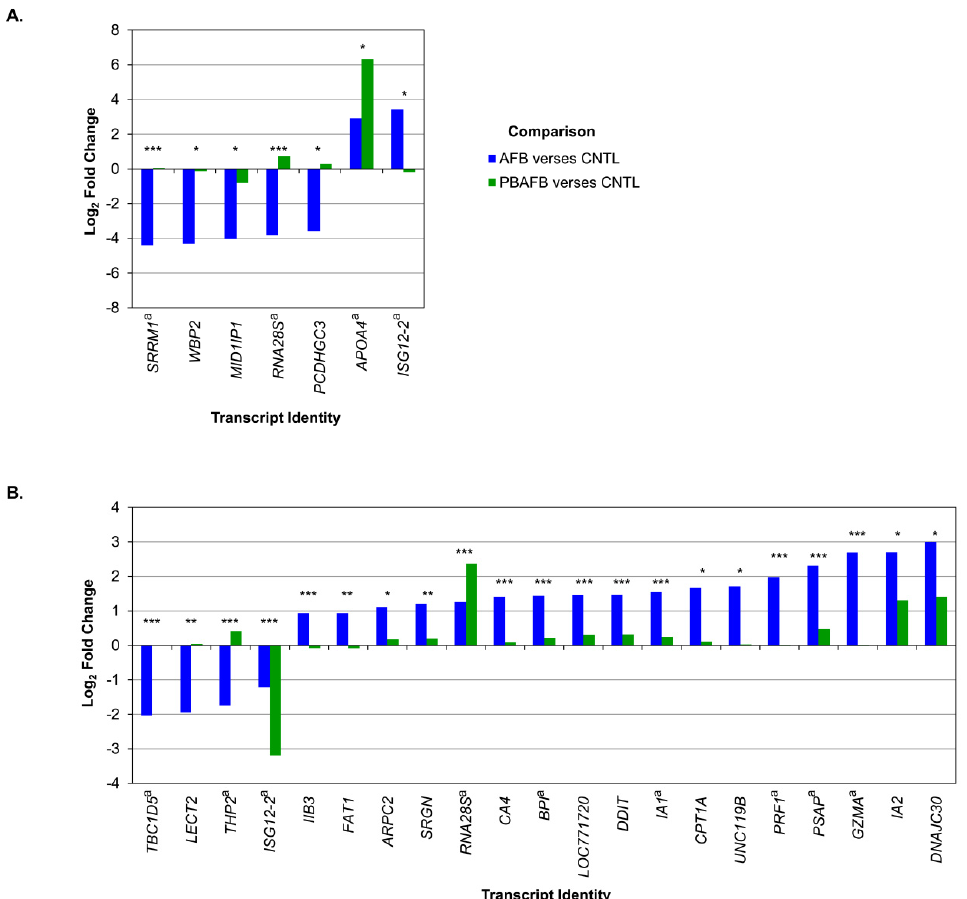
Figure 3. Oral probiotics mitigate gene expression changes induced by aflatoxin B 1 (AFB 1 ). ( A) Liver. ( B) Spleen. Graphs show annotated transcripts from each tissue with significant differential expression in the AFB 1 -treated group (AFB) versus the control group (CNTL) and in the probiotic + AFB 1 group (PBAFB) verses AFB. Bars illustrate log 2 fold change in AFB verses CNTL ( blue ) or PBAFB verses CNTL ( green ). Significance of the probiotics (PBAFB verses AFB) is represented by the number of asterisks (*: 0.05 > p -value > 0.01, **: 0.01 > p -value > 0.001, ***: p -value < 0.001). Genes with multiple significant transcripts are indicated by a ; only the most significant transcript in PBAFB verses AFB is shown. Apolipoprotein A-IV ( APOA4 ), actin-related protein 2/3 complex subunit 2-like ( ARPC2 ), bactericidal permeability-increasing protein ( BPI ), carbonic anhydrase IV ( CA4 ), carnitine O-palmitoyltransferase 1, liver isoform ( CPT1A ), DNA-damage-inducible transcript 4 ( DDIT ), DnaJ homolog subfamily C member 30 ( DNAJC30 ), FAT tumor suppressor homolog 1 ( FAT1 ), granzyme A ( GZMA ), MHC class I antigen alpha chain 1 ( IA1 ), MHC class I antigen alpha chain 2 ( IA2 ), MHC class II antigen beta chain 3 ( IIB3 ), ISG12-2 protein-like ( ISG12-2 ), leukocyte cell-derived chemotaxin-2 ( LECT2 ), uncharacterized LOC771720 ( LOC771720 ), MID1 interacting protein 1 ( MID1IP1 ), protocadherin gamma subfamily C3 ( PCDHGC3 ), perforin 1 ( PRF1 ), presaposin ( PSAP ), 28S ribosomal RNA gene ( RNA28S ), serglycin ( SRGN ), serine/arginine repetitive matrix protein 1 ( SRRM1 ), TBC1 domain family member 5 ( TBC1D5 ), beta-defensin 2 ( THP2 ), unc-119 homolog B ( UNC119B ), and WW domain-binding protein 2 ( WBP2